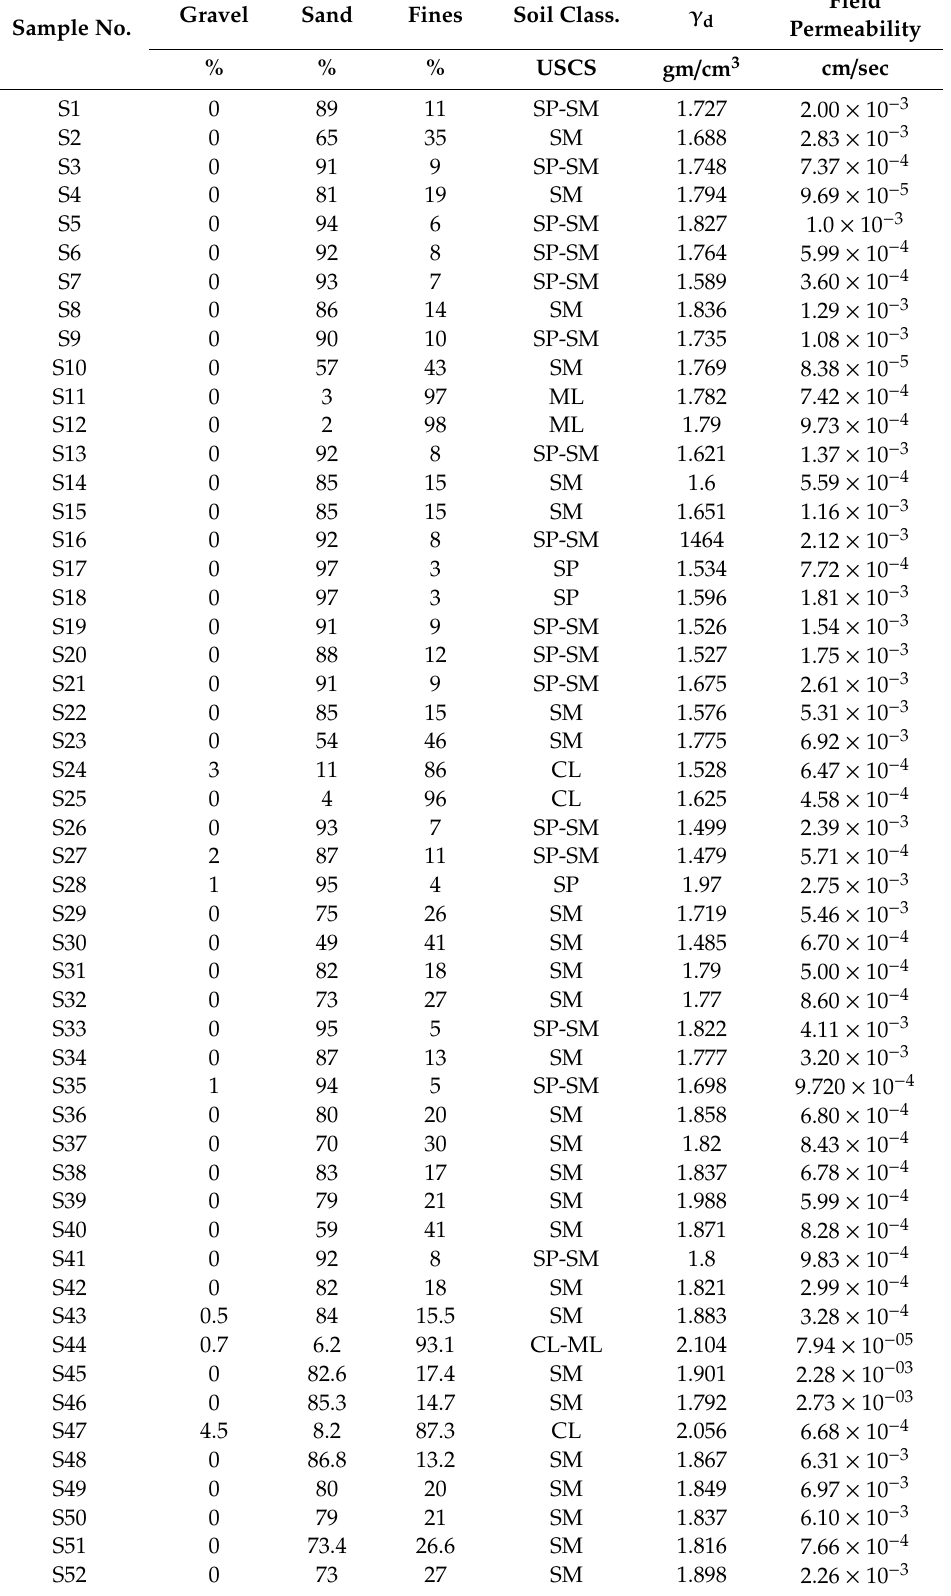
Table 2. Field permeability data for